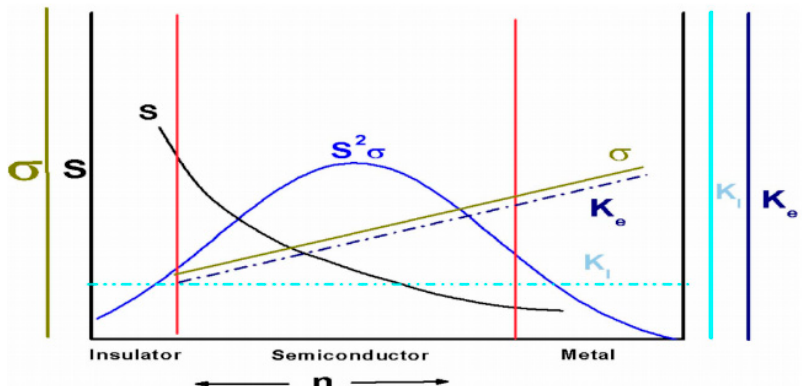
Figure 3. Relationship between figure of merit ZT and other parameters such as electrical conductivity σ , Seebeck coefficient S, power factor S 2 σ , electronic thermal conductivity Ke, thermal conductivity of the network Kl and total thermal conductivity K [16].